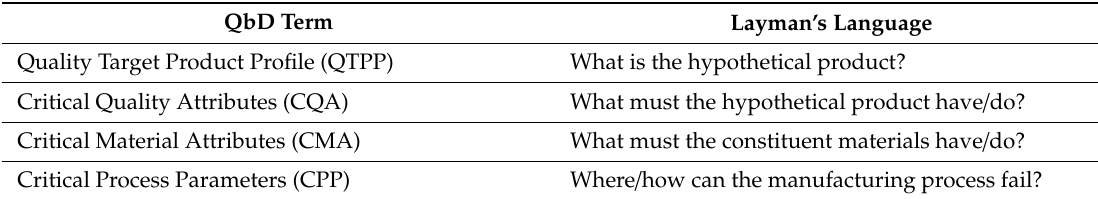
Table 1. Equivalent QbD and layman’s